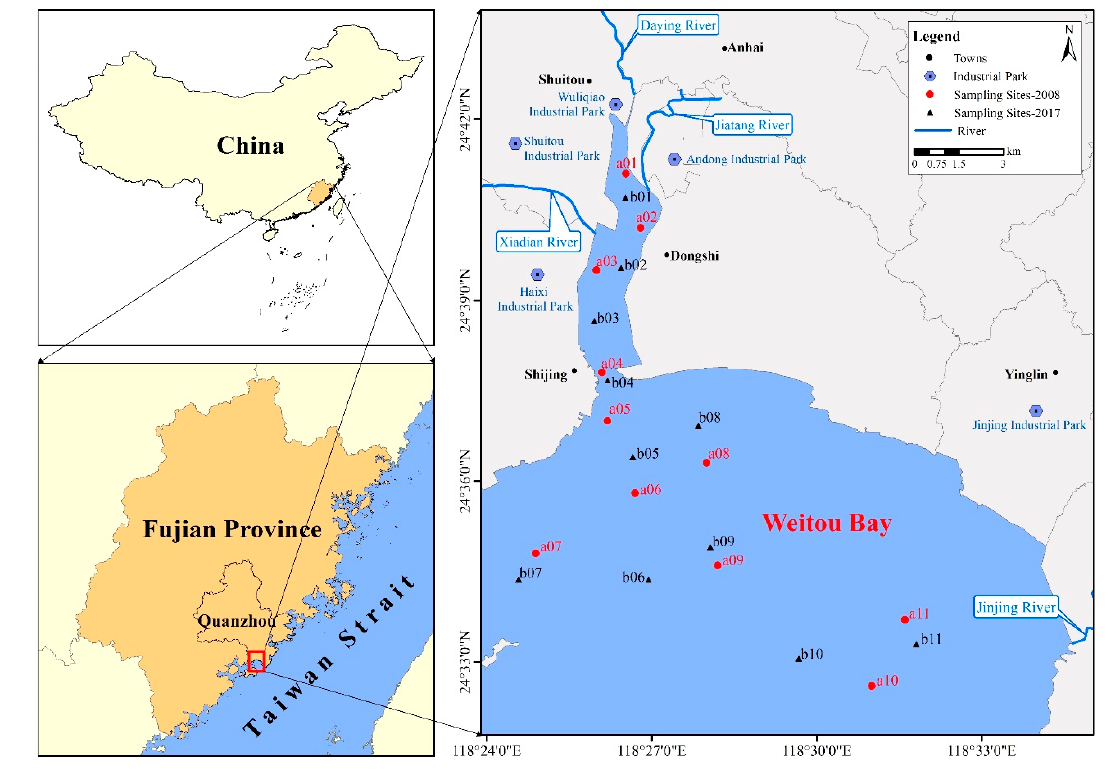
Figure 1. Location of the study area in Weitou Bay, China.